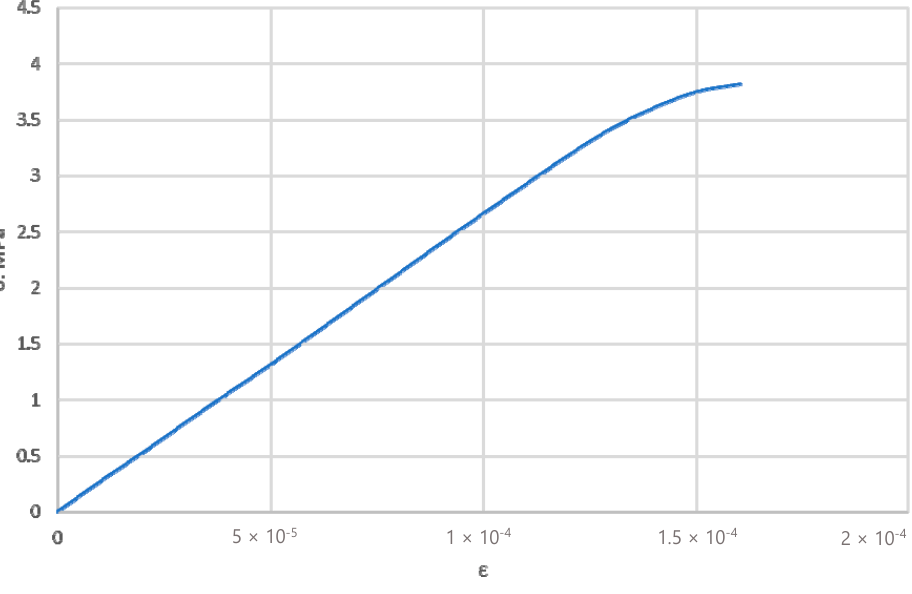
Figure 4. The true stress–strain curve for finely dispersed coke with zero